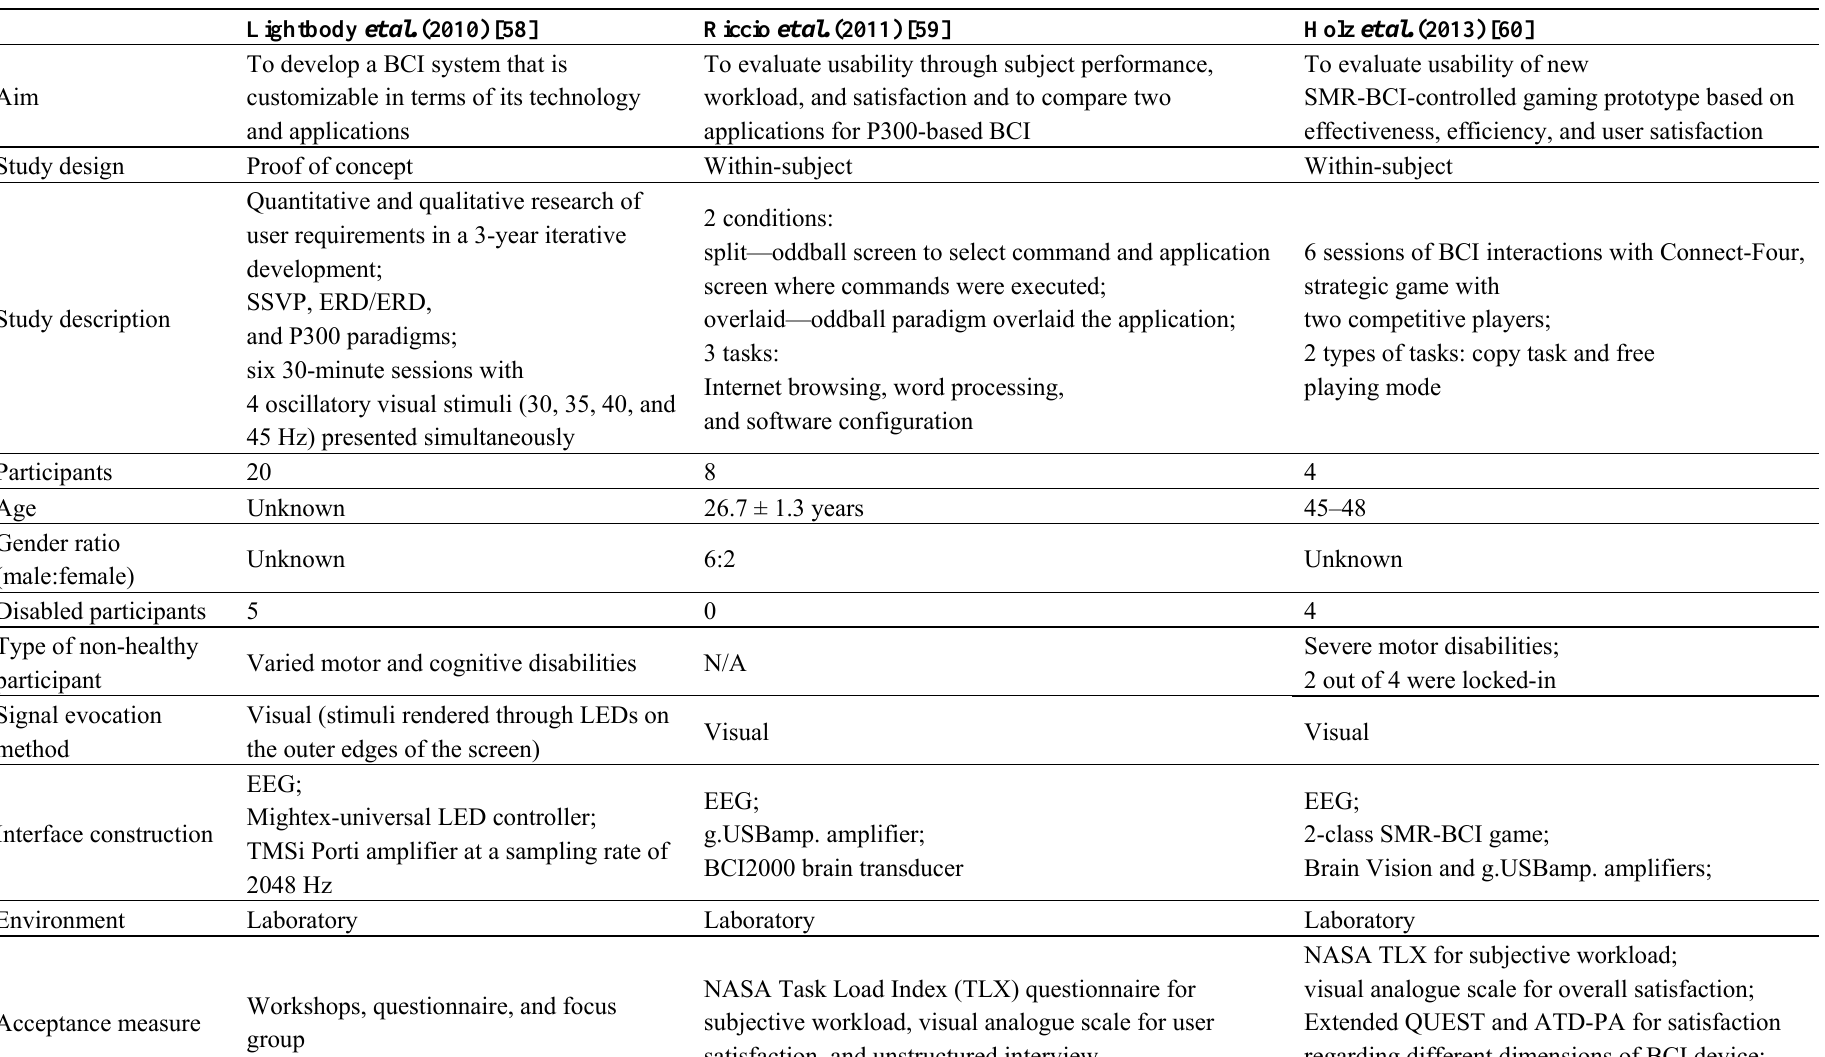
Table 3. Studies selected for